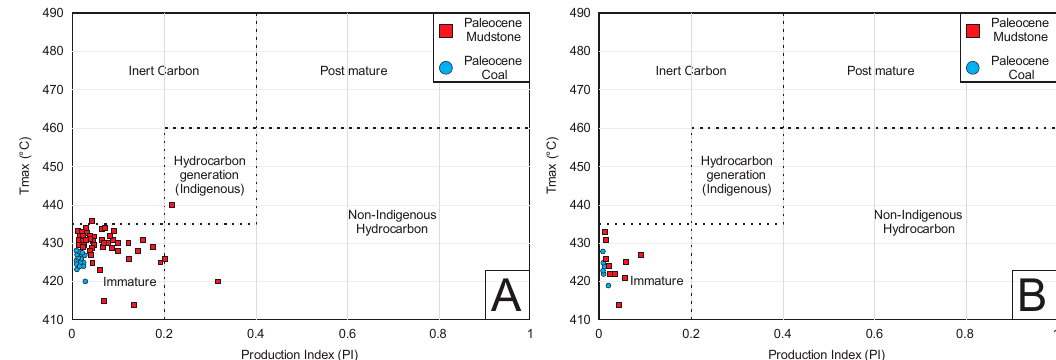
Figure 13. Cross plot of production index (PI) versus Tmax ( ℃ ) to identify source rock maturity in the Cerrejón Formation of the ( A ) ANH-CARRETALITO-1 and ( B ) ANH-CAÑABOBA-1 wells.